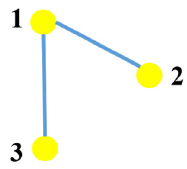
Figure 2. The topology of a WASN with three nodes .